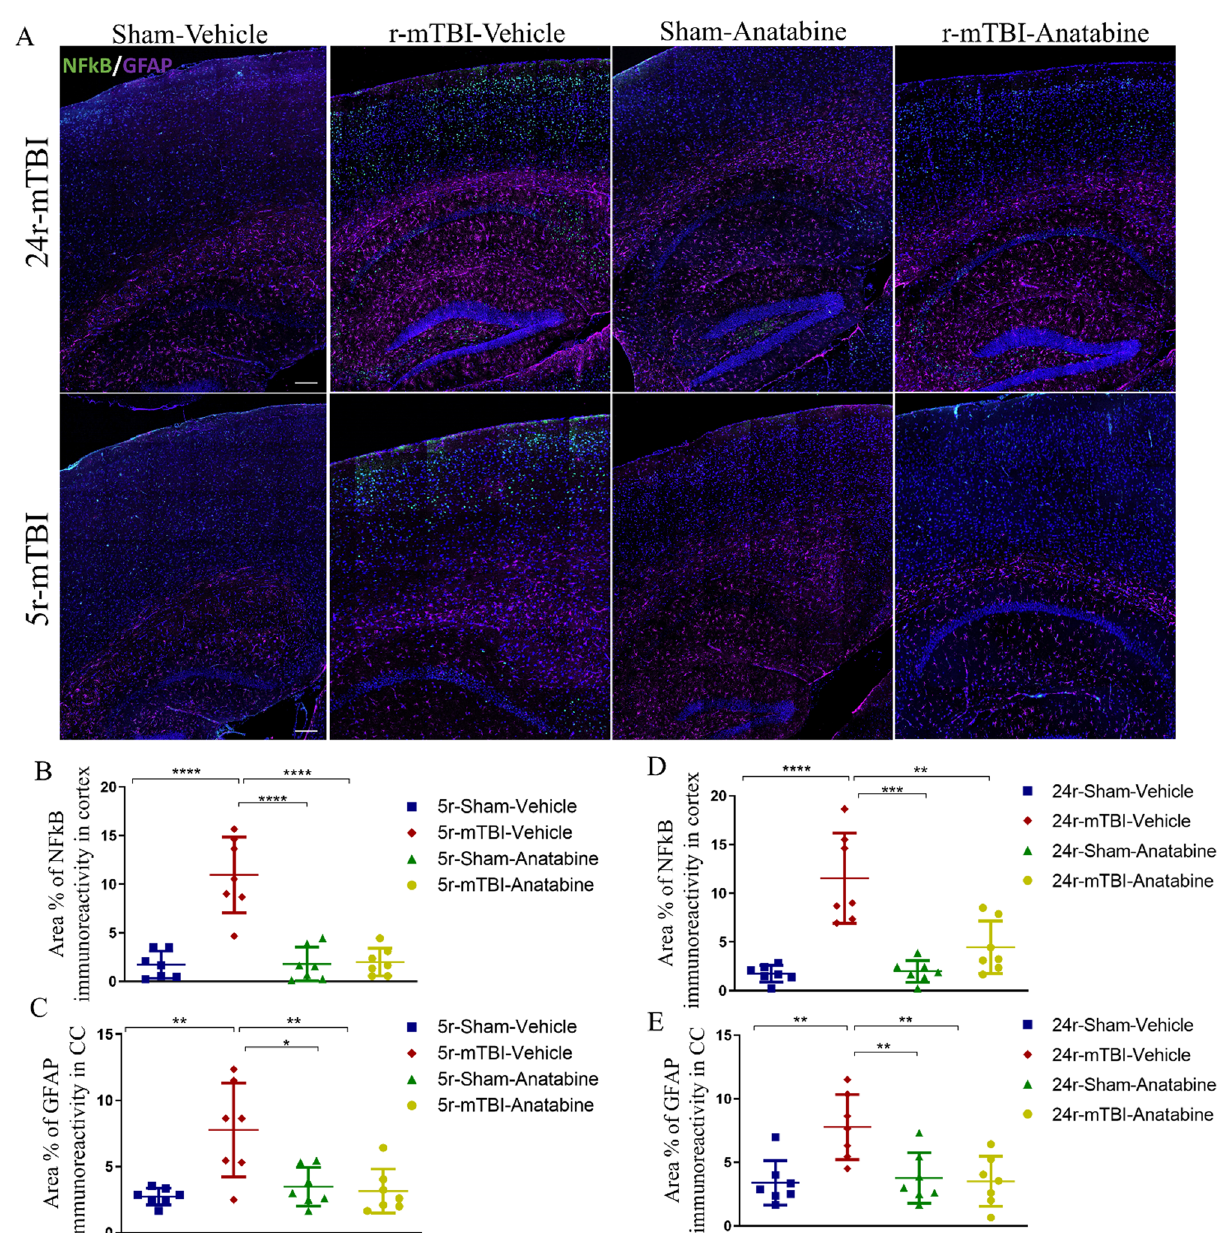
Figure 7. Immunofluorescent analysis of GFAP and NFkB. ( A ) Representative images of NFkB/GFAP in cortex, corpus callosum (CC) and hippocampus. ( B , C ) Quantification of area coverage of NFkB in cortex and GFAP in CC, respectively, in 5r-mTBI cohort. ( D , E ) quantification of area coverage of NFkB in cortex and GFAP in CC, respectively, in 24r-mTBI cohort. In the 24r-mTBI group, TBI produced a significant increase of GFAP in CC (( E ), p < 0.001) and of NFkB in cortex (( D ), p < 0.0001) compared to 24r-sham-vehicle. Similarly, in the 5r-mTBI group, TBI induced GFAP (( C ), p < 0.001) and NFkB (( B ), p < 0.0001) immunoreactivity compared to 5r-sham-vehicle mice. Treatment with anatabine decreased GFAP (24r-mTBI p < 0.01; 5r-mTBI p < 0.01) and NFkB (24r-mTBI p < 0.001; 5r-mTBI p < 0.0001) in r-mTBI mice compared to the respective r-mTBI-vehicle mice. Data analyzed using two-way ANOVA. Scale bar equal 200